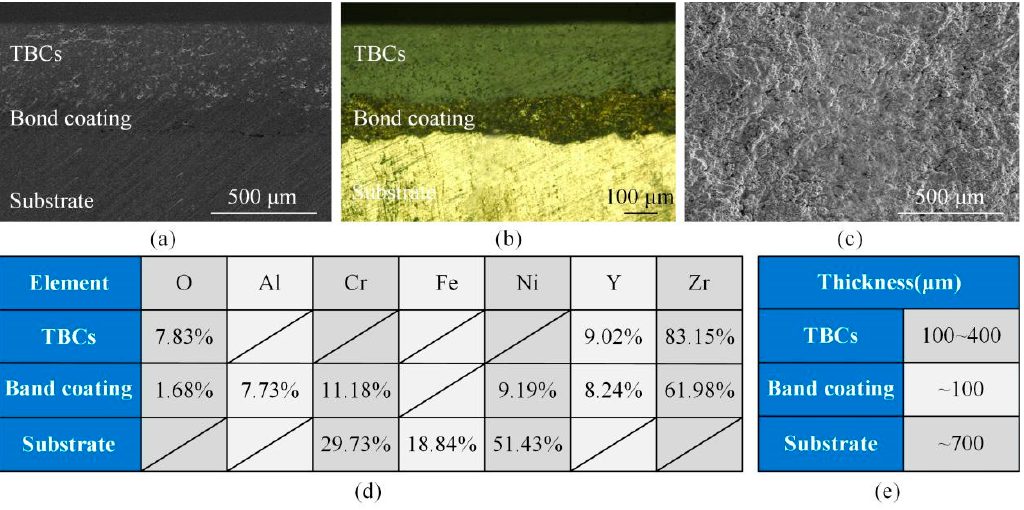
Figure 2. Ceramic thermal barrier coatings (TBCs) / substrate multilayer materials ( a ): SEM image ( b ): Metallographic image ( c ): Surface of TBCs ( d ): Element contents of multilayer materials ( e ): Thickness of the multilayer materials.